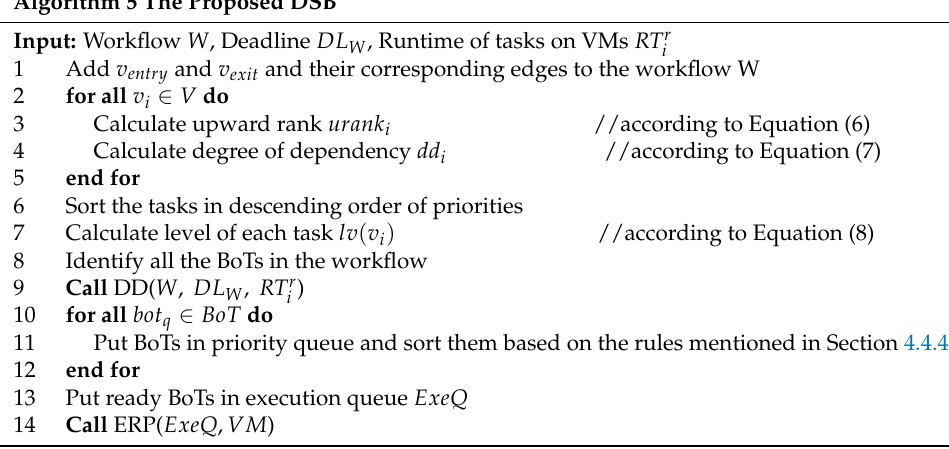
Algorithm 5 The Proposed